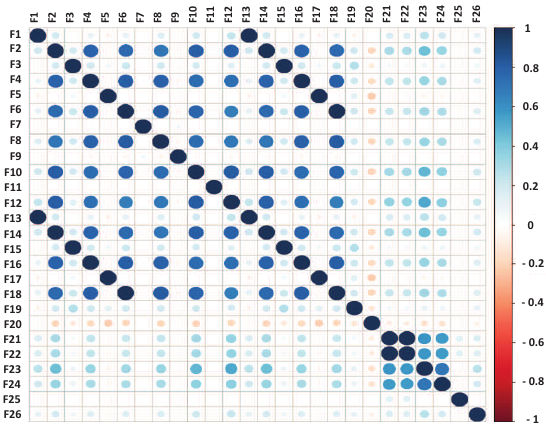
Figure 2. Correlation matrix of user 1.